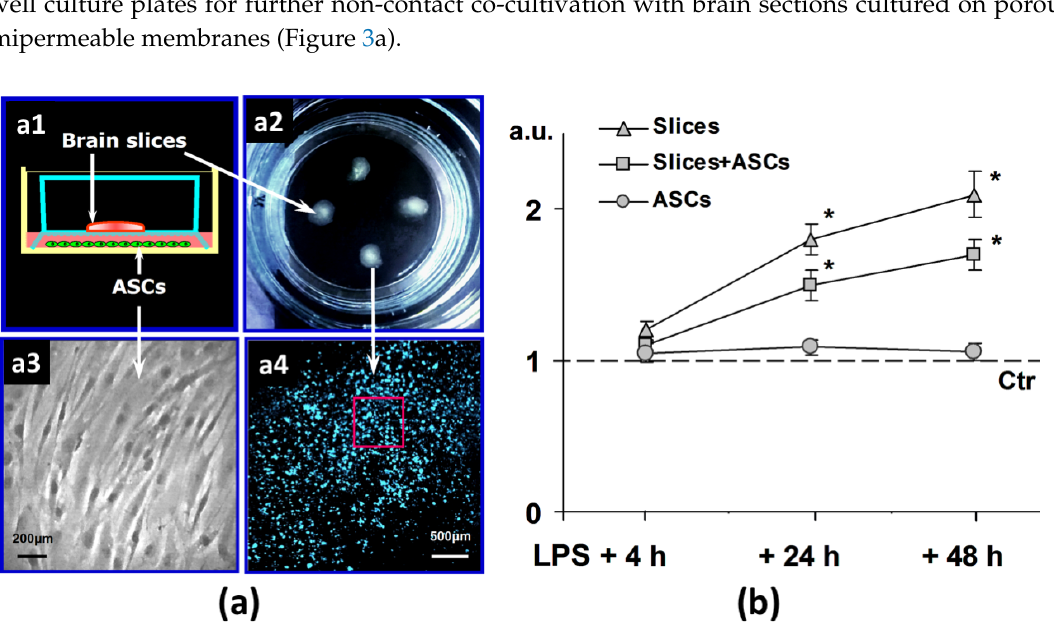
Figure 3. ( a ) The scheme of non-contact organotypic brain slice co-culture with adipose-derived stem cells (ASCs): ( a1 ) for non-contact co-culture the inserts with brain slice cultures were placed into the 6-well plates with adherent culture of ASCs; ( a2 ) brain slices were transferred onto inserts with porous semitransparent membranes for culturing; ( a3 ) the microphotograph of ASC culture, phase contrast, 2nd passage; ( a4 ) the analyzed area of slices is shown by the red square. Nuclei were counterstained with Hoechst 33342. ( b ) The relative amount of lactate dehydrogenase (LDH) in the culture medium 4, 24 or 48 h after lipopolysaccharide (LPS) alone or in combination with non-contact ASCs co-culture (n = 8). *—statistically significant difference compared with control ( p < 0.05). n = the number of slices in the group.